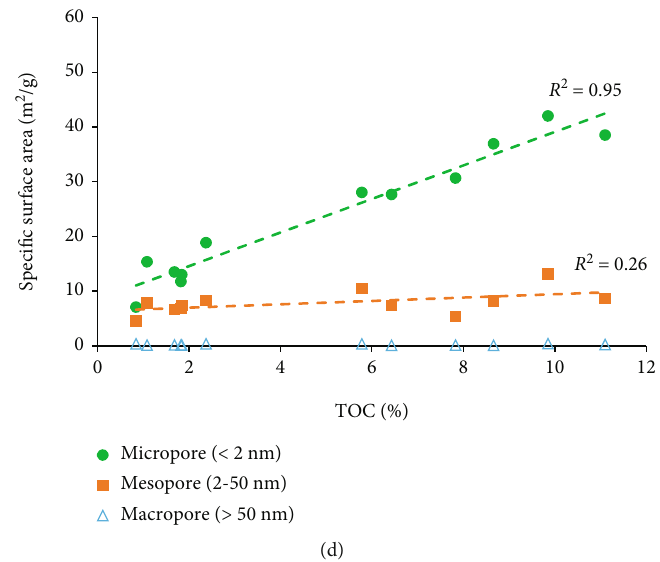
Figure 8: Cross-plots of TOC content with (a) total PV, (b) total SSA, (c) PV, and (d)